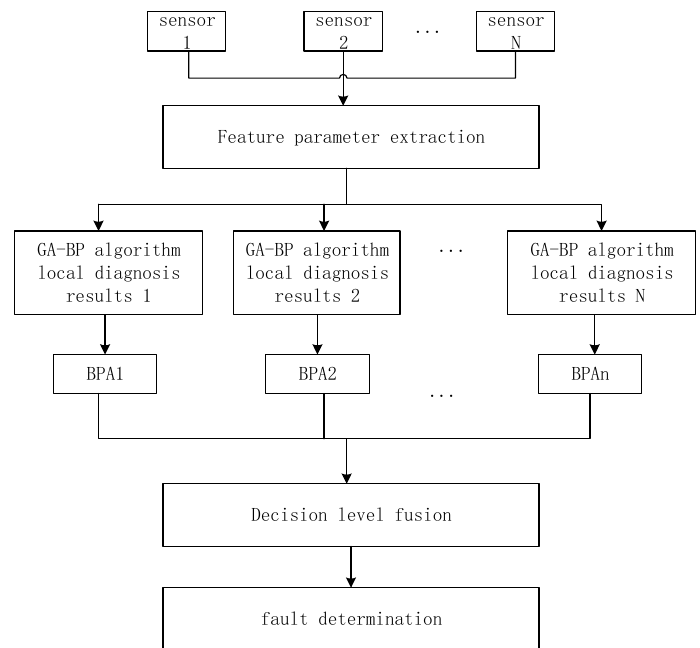
Figure 1. Multi-sensor decision-level fusion.